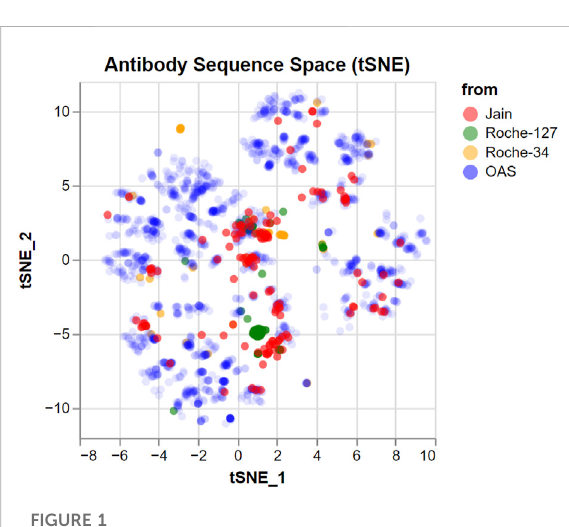
FIGURE 1 tSNE embedding of the sequence space covered by the datasetsusedinthisstudy.2,000randomsequencesfromtheOAS dataset are added for comparison, with a lower opacity. Groups of nearbypointsrepresentsimilarsequenceswhicharedifferent from the others. However, larger distances between groups should not be